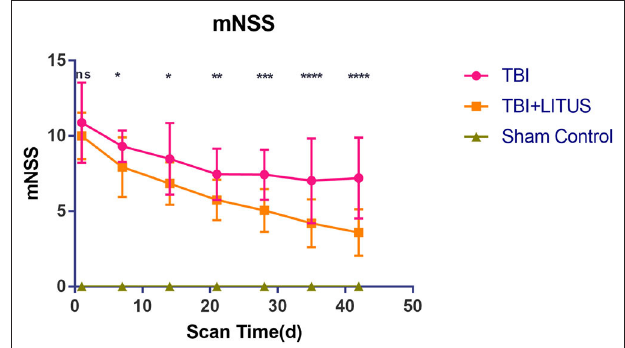
FIGURE 8 | Trends of mNSS of Sham Control, TBI and TBI + LITUS groups. Data are mean ± SD, n = 15. Tukey’s post-hoc test for TBI vs. TBI + LITUS, * P < 0.05, ** P < 0.01, *** P < 0.001, **** P <